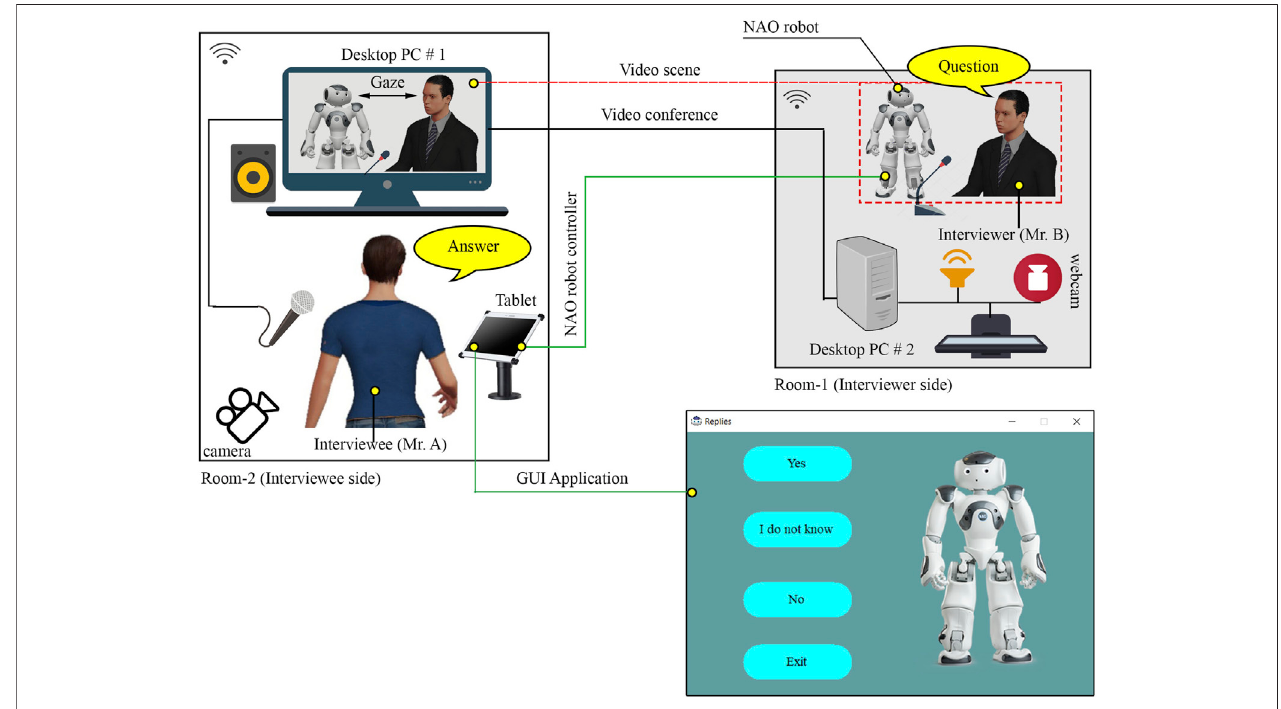
FIGURE 1 | Robot condition (with interviewer ’ s gaze toward the robot